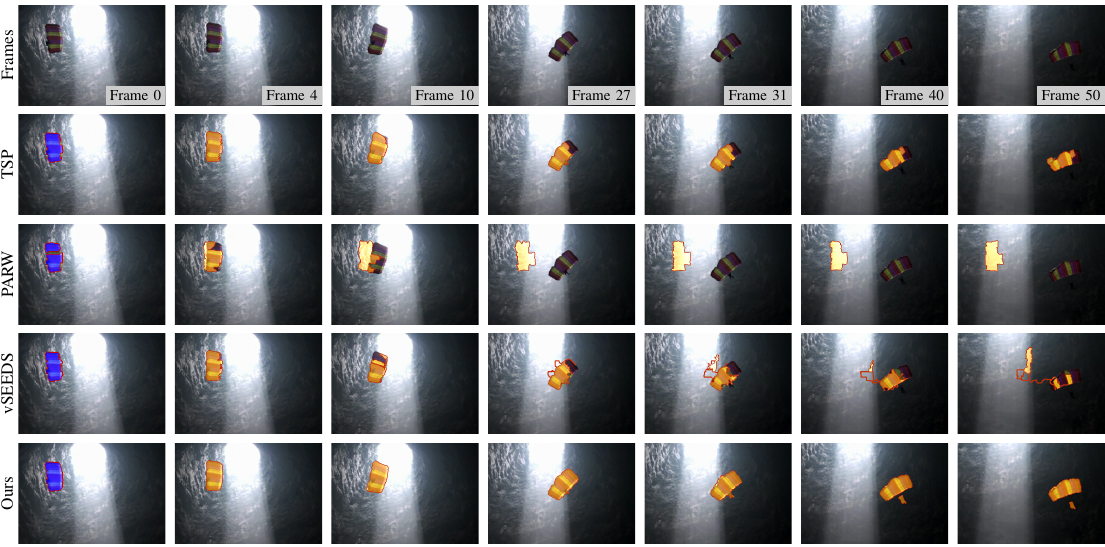
Figure 9. Segmentation results of a moving target that becomes two separated parts during the